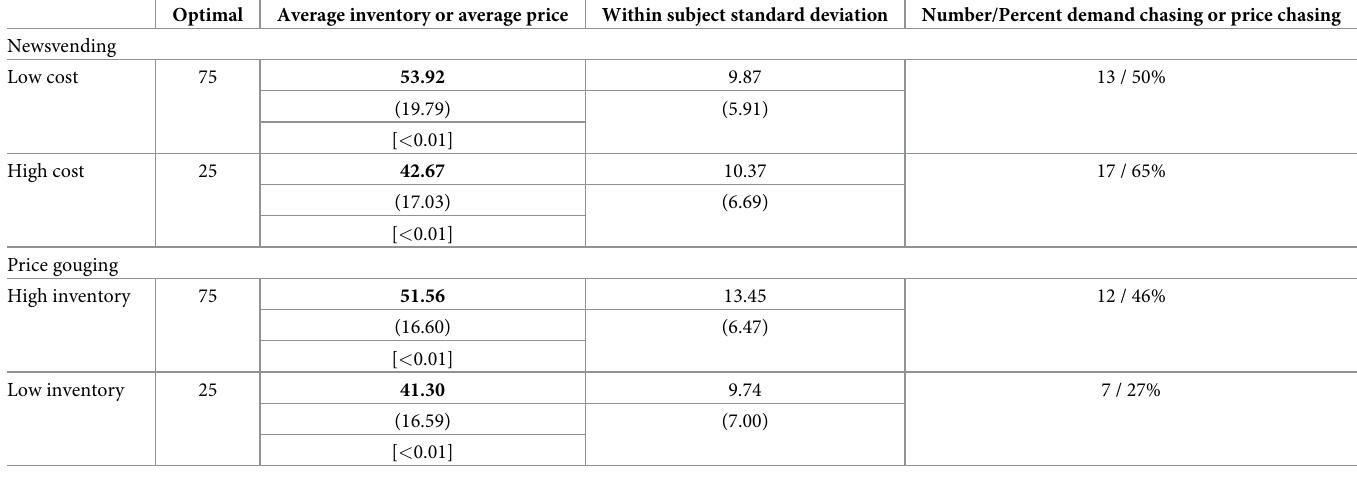
Table 2. Descriptive statistics of inventory and price choices.